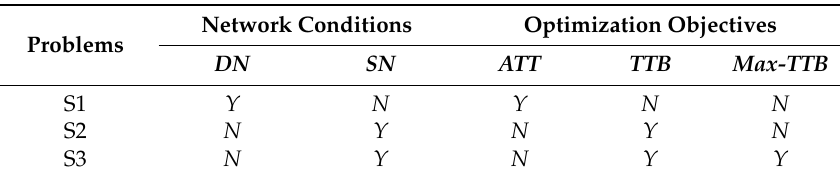
Table 2. Definitions of the three problems.